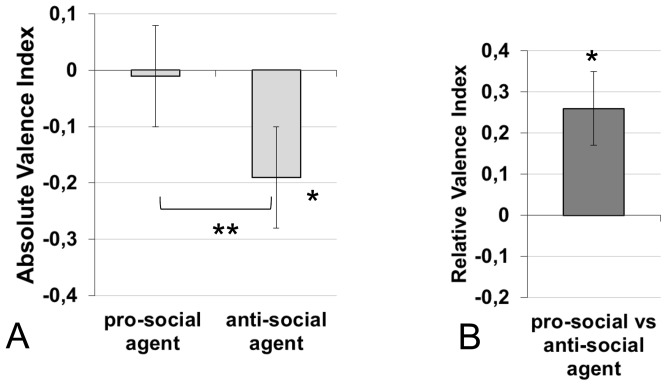
Average indexes for 29 months-olds.
A. Average Absolute Valence Index for 29-months-old toddlers computed over the responses to the individual questions regarding the pro-social agent and the anti-social agent separately. *p<.05 (between subjects),**p<.02 (within subjects). A positive score indicates a positive verbal statement toward the agent and vice versa for negative scores. The error bars correspond to one between-subject standard error above and below the mean. B. Average Relative Valence Index computed over the responses to the contrastive questions. A positive score indicates a more positive assessment of pro-social than the anti-social agent, vice-versa for negative scores. The error bars correspond to one between-subject standard error above and below the mean. *p<.05.